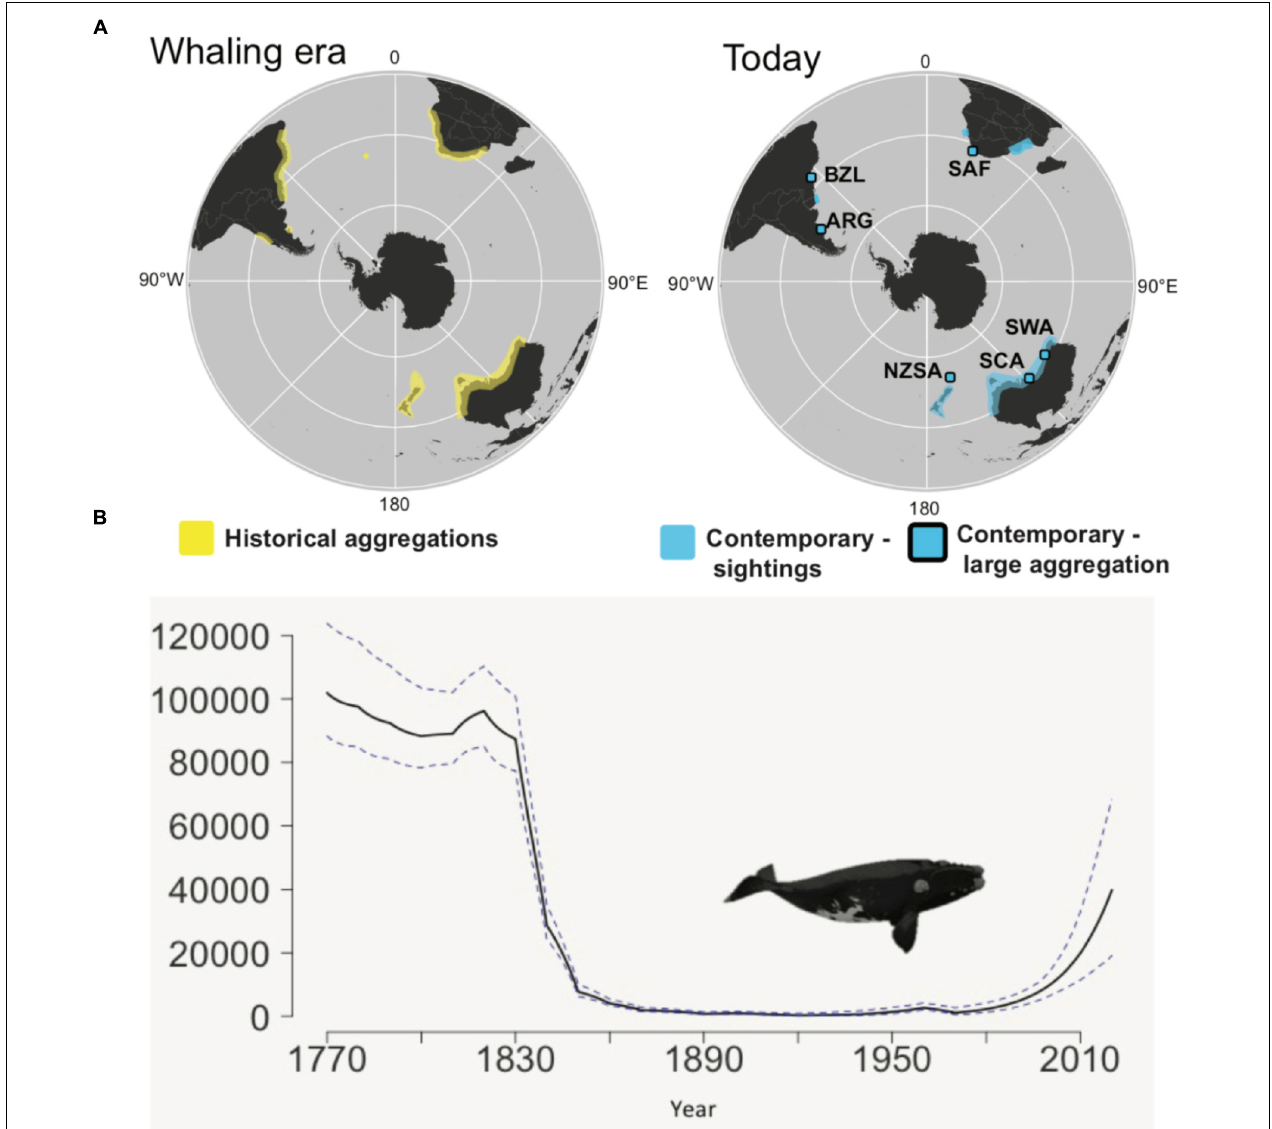
FIGURE 1 | Change in distribution and abundance of southern right whales. (A) Shows historical and contemporary wintering distributions (Figure 1 from Carroll et al., 2018), and (B) shows decline in abundance and subsequent recovery (solid line is the mean, dashed line shows upper and lower 95% CI). Modified Figure 1 from Jackson et al. (2008). Contemporary sightings are divided into regions where large aggregations are seen during winter: Argentina (ARG), Brazil (BZL), South Africa (SAF), southwest Australia (SWA), south central Australia (SCA), and New Zealand sub-Antarctic (NZSA) and regions where sightings are typically of small numbers of individuals per year. The large aggregations are IWC management units and correspond to historical whaling grounds, although another 5 whaling grounds show little sign of recovery. Summer feeding areas are poorly described and so not shown.